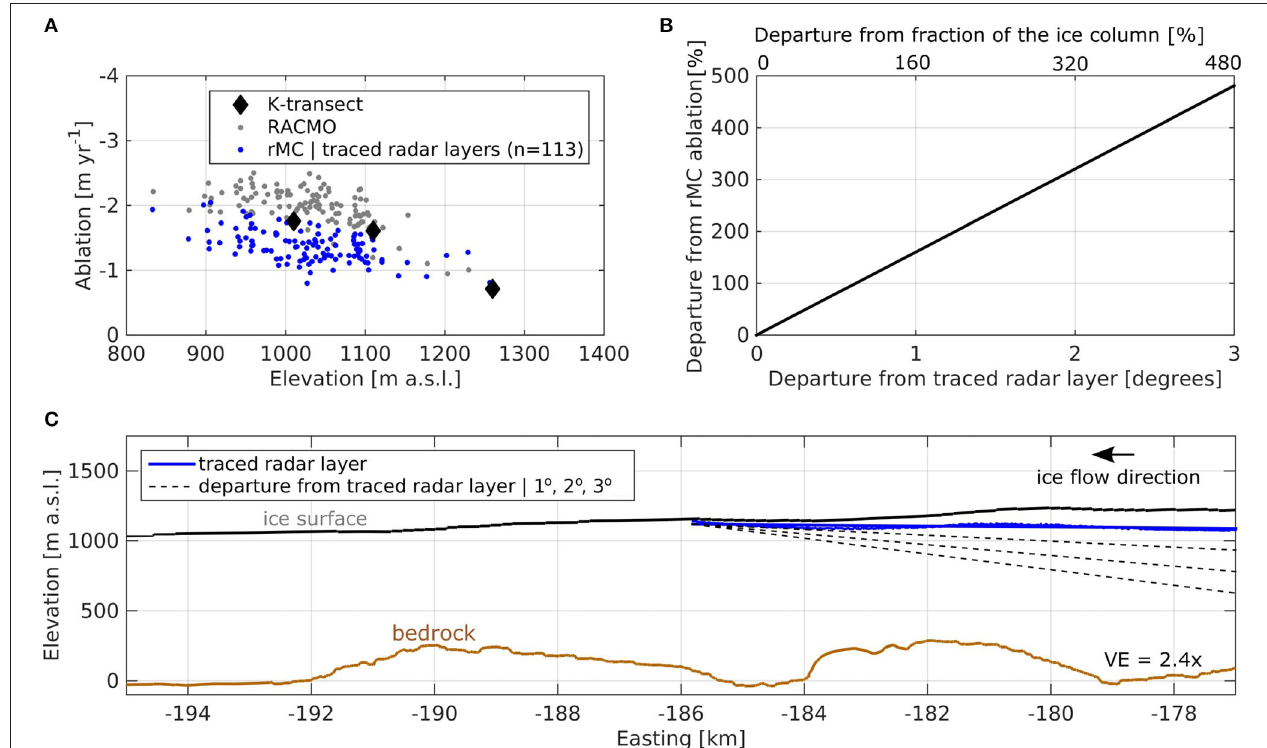
FIGURE 8 | Mass-conserving ablation. (A) Radar-derived, mass-conserving (rMC) ablation rates (blue dots), K-transect in situ observations (black diamonds), and regional climate model RACMO output (gray dots) plotted against elevation. (B) Plot shows the effect of using englacial particle paths that are departed from radar layers. The fraction of the ice column (top x-axis) increases as departure from the traced radar layer (bottom x-axis) increases. Increased fractions of the ice column result in increased ablation rates (y-axis). Departures are expressed relative to the traced radar layer shown in (C) . (C) Along-flow cross section showing IceBridge ice surface (black line), bed (brown line), and traced radar layer (blue line), presented the same as in Figure 6 but without the complete radiostratigraphy and with less vertical exaggeration. Hypothetical particle paths dipping 1 ◦ , 2 ◦ , and 3 ◦ from the traced radar layer (dashed black lines) are also